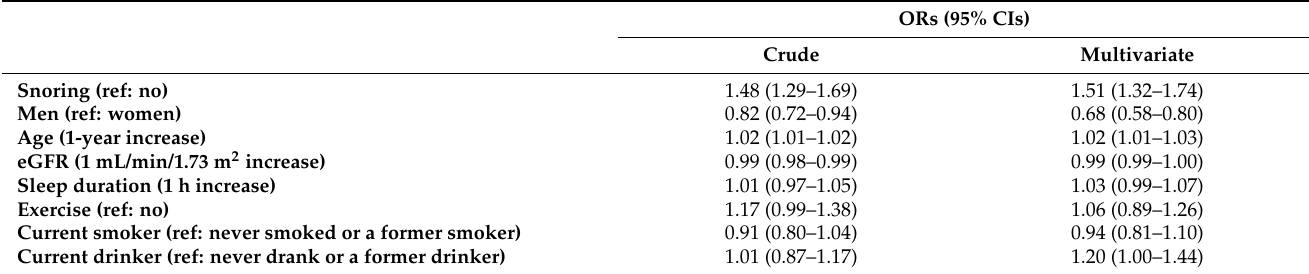
Table 4. Association between snoring status and incidence of MetS.